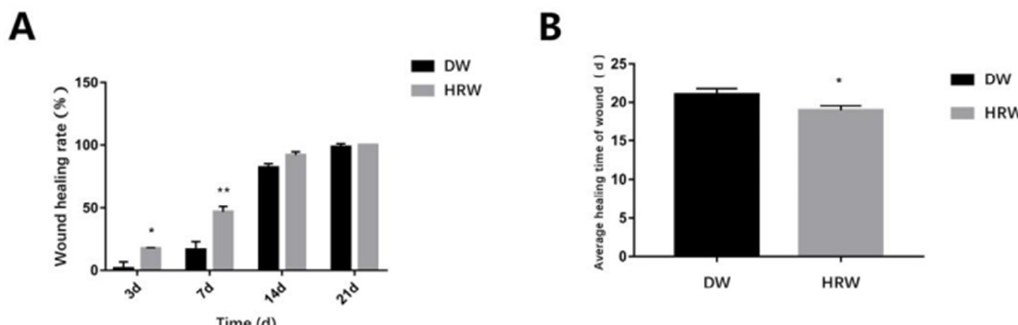
Figure 3. ( A ) The wound healing rate on days 3, 7, 14, and 21 between HRW and DW. ( B )Skin wound was completely covered by the granulation tissue was considered the healing time of wound. Com- pared with two groups, * p < 0.05, ** p <